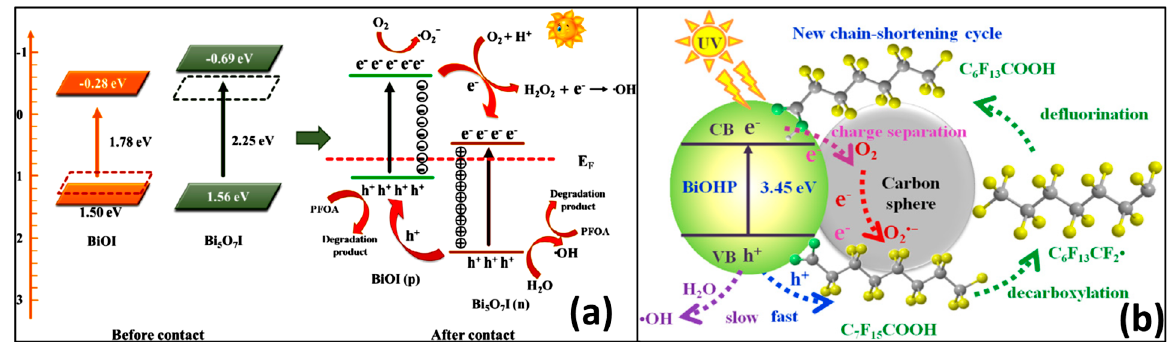
Figure 4. Charge separation and PFOA degradation ( a ) at the p-n heterojunction of BiOI@Bi 5 O 7 I (reprinted from [92], copyright (2020) with permission from Elsevier) and ( b ) in BOHP/CS composites (reprinted from [95], copyright (2020) with permission from Elsevier).